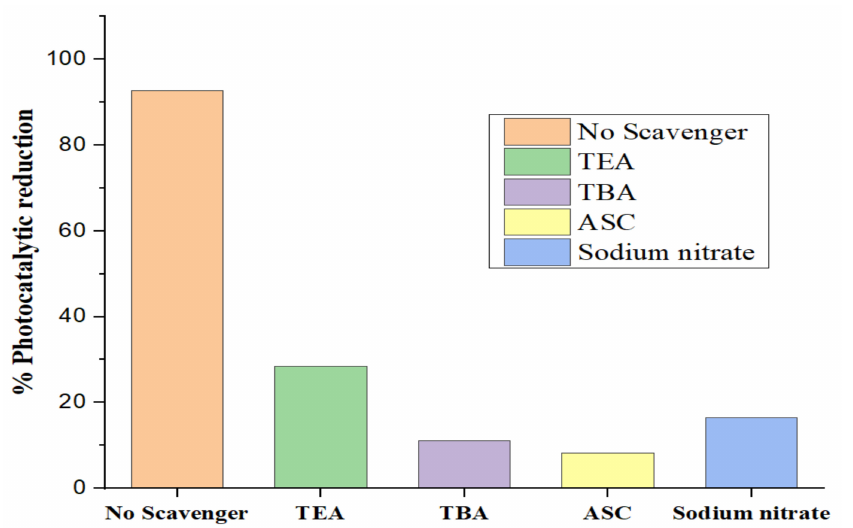
Figure 12. The results of the radical scavenging